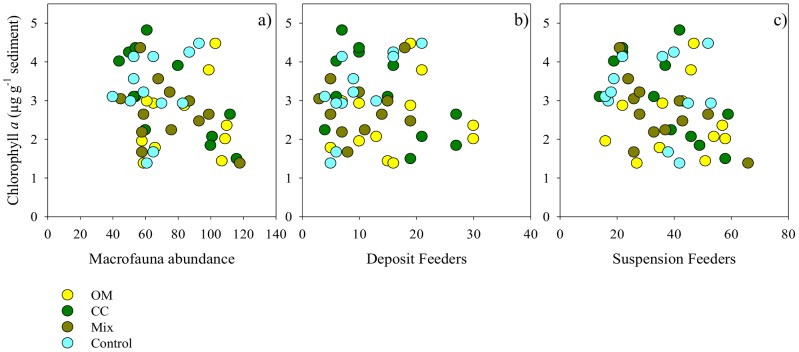
Biplots showing the relationship between chlorophyll a vs. macrofauna abundance, and the main feeding guilds.The panels show the general relationship across the sampling area. Chlorophyll a (µg g−1 sediment), total macrofauna abundance (number of individuals), main feeding guilds (abundance of deposit and suspension feeders; DF and SF, respectively). Plots are raw data. (Treatments: Organic Matter, Calcium carbonate, Mix, Control).